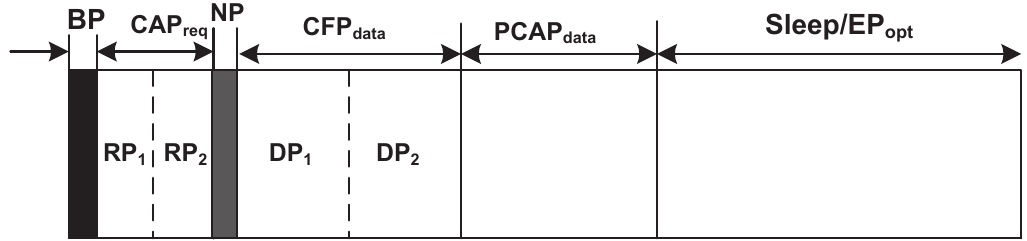
Figure 2. Superframe